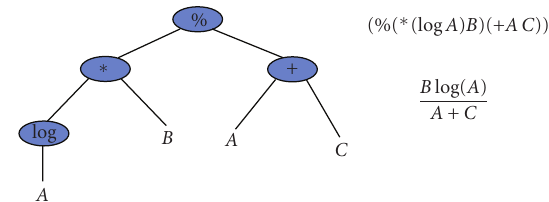
Figure 2: A mathematical expression represented hierarchically by its parse tree.